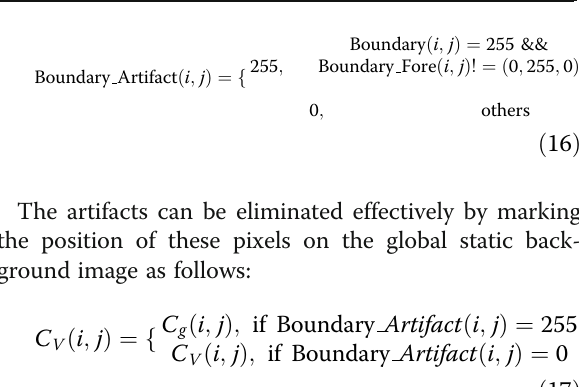
Table 1 Characteristics of the test sequences Test Resolution Camera setting Frame sequence BreakDancers 1024 ×